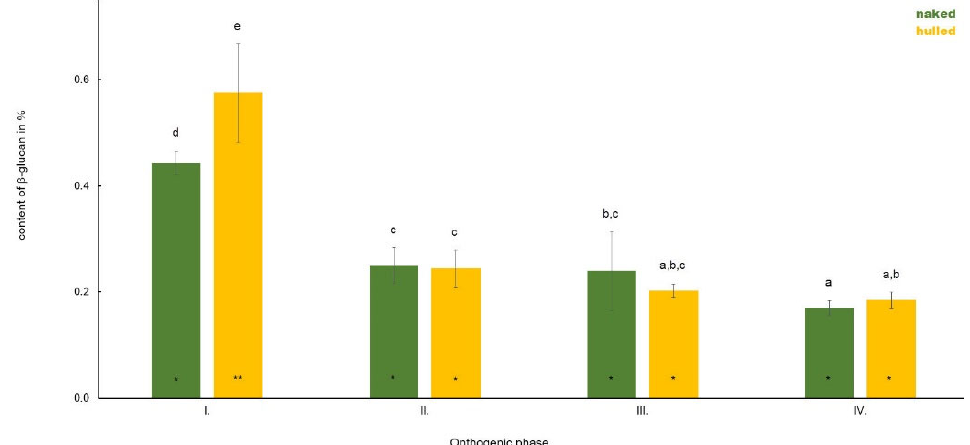
Figure 5. Comparison of the content of β -D-glucan in the root of hulled and naked oat samples during plant ontogenesis. Different letters indicate a statistically significant difference between individual seed types (naked and hull) in specific ontogenetic phase evaluated by ANOVA (LSD, p ≤ 0.05). Star symbols (* and **) represent statistically significant difference between naked and hulled samples evaluated for each ontogenetic phase individually by ANOVA (LSD, p ≤ 0.05).